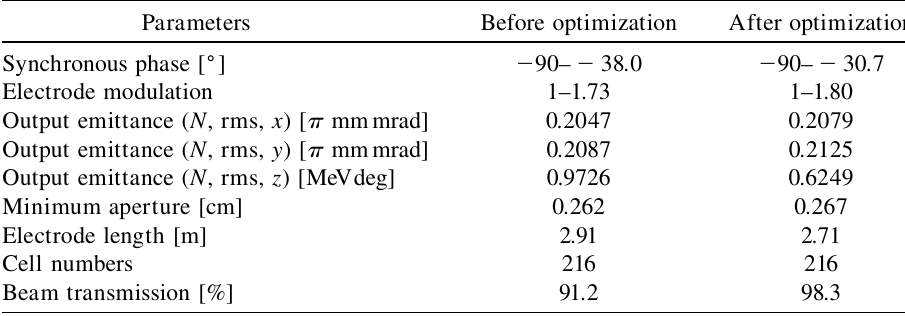
TABLE II. Main beam dynamics parameters of the PKU deuteron RFQ by LANL RFQ design codes.